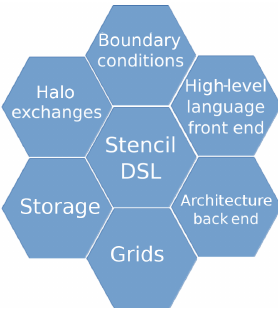
Figure 9. The GridTools separation of concerns provides some el- ements of the taxonomy of components needed by modelling pro- grammes and identifies some of the interfaces